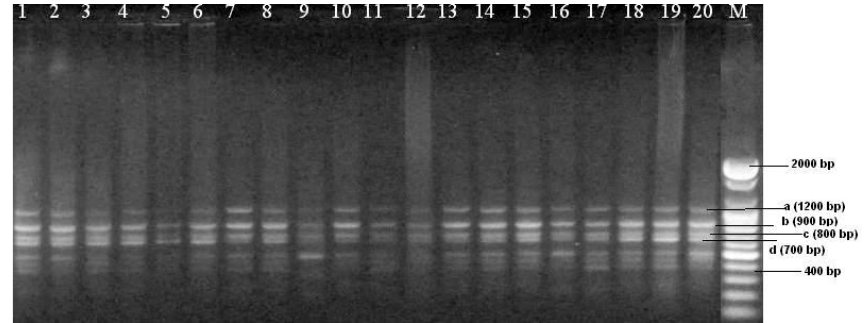
Figure 2. RAPD profiles using primer OPA-07. On the gel ‘a’, ‘b’, ‘c’ and‘d’ bands were monomorphic for all experimental animals.